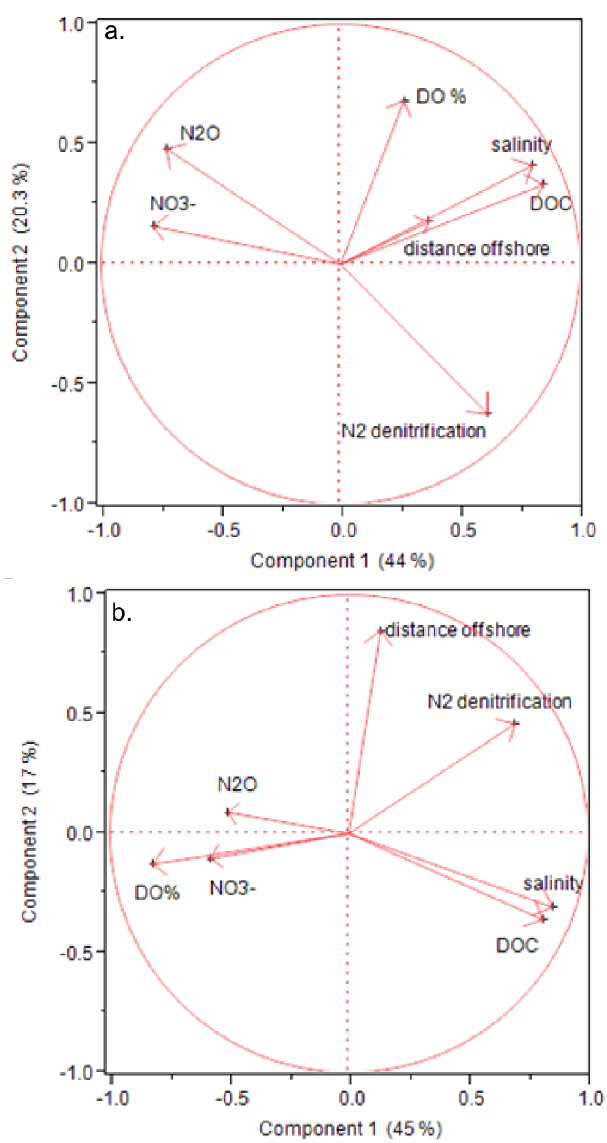
Figure 4. Principal component analysis (PCA) of the major nitrogen cycling geochemical solutes in porewater from ( a ) Port Jefferson Harbor and ( b ) Stony Brook Harbor.